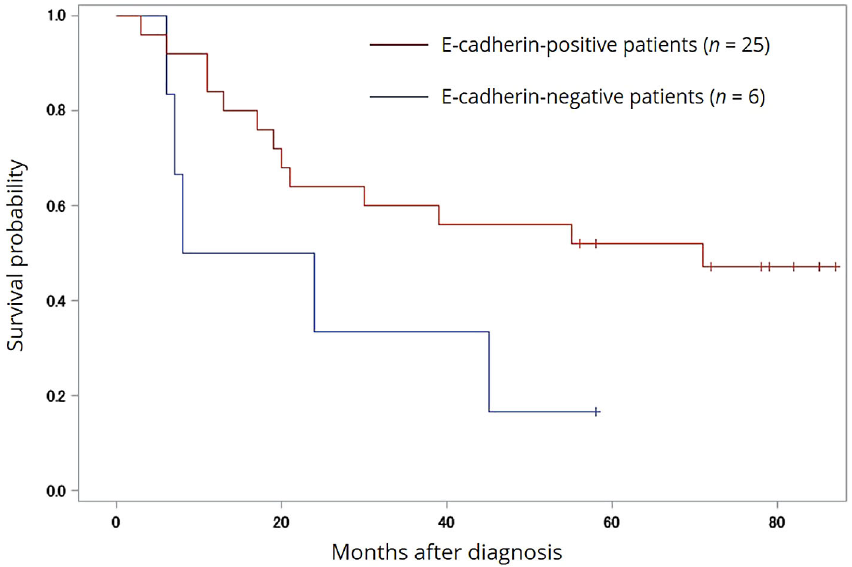
Figure 2. Survival analysis of E-cadherin in univariate analysis. OS stratified by the E-cadherin negativity of MM cells. A statistical significance in OS was found between the E-cadherin-positive and -negative groups (Log-rank p =0.0644, Wilcoxon p =0.0682, -2Log (LR) p =0.0443). Hashmarks indicate surviving patients at last visit. OS, overall survival; MM, multiple